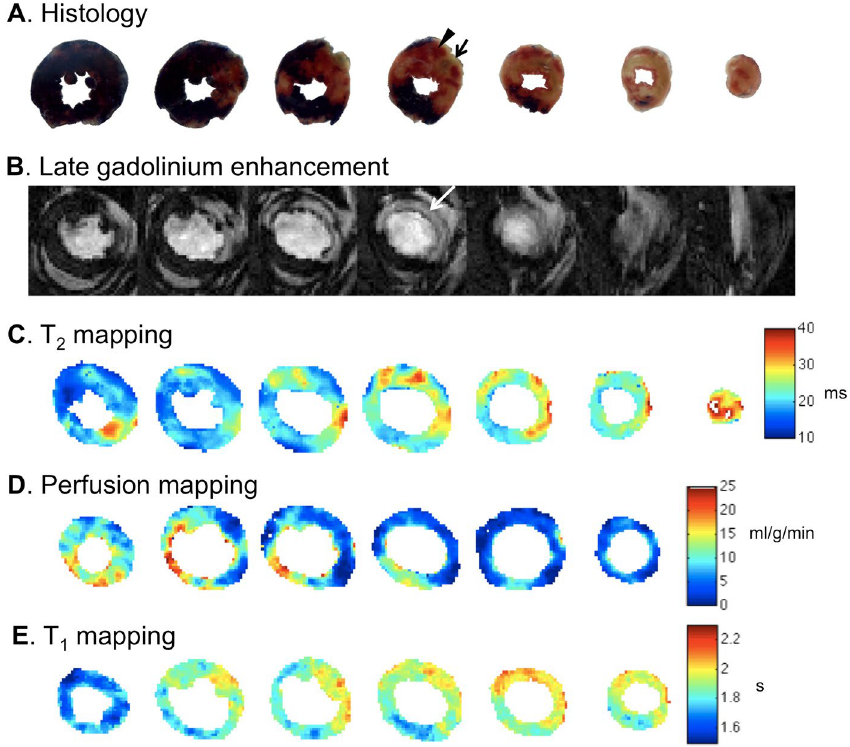
Figure 2. Representative histology and CMR images of a mouse heart subjected to control IRI protocol. ( A ) Histological staining of transverse slices of mouse heart prepared ex vivo at approximate positions of MR scanning. TTC staining allows identification of MI as area colored off-white (example indicated by arrow). Evans blue staining allows identification of AAR as area not stained blue (example indicated by arrowhead). ( B ) LGE imaging showing spatially distinct areas of hyper-enhancement in areas of MI (example indicated by arrow). ( C) T 2 -mapping showing spatially distinct areas of elevated T 2 (ms) (yellow-red appearance) compared to normal region (dark blue color). ( D ) ASL perfusion mapping showing spatially distinct areas of decreased perfusion (ml/g/min) (dark blue appearance) compared to normal region (yellow-red color). ( E) T 1 -mapping showing spatially distinct areas of elevated T 1 (s) (yellow-red appearance) compared to normal region (dark blue color). Histology and MR images have different slice thicknesses and cardiac contraction states and therefore should not be compared